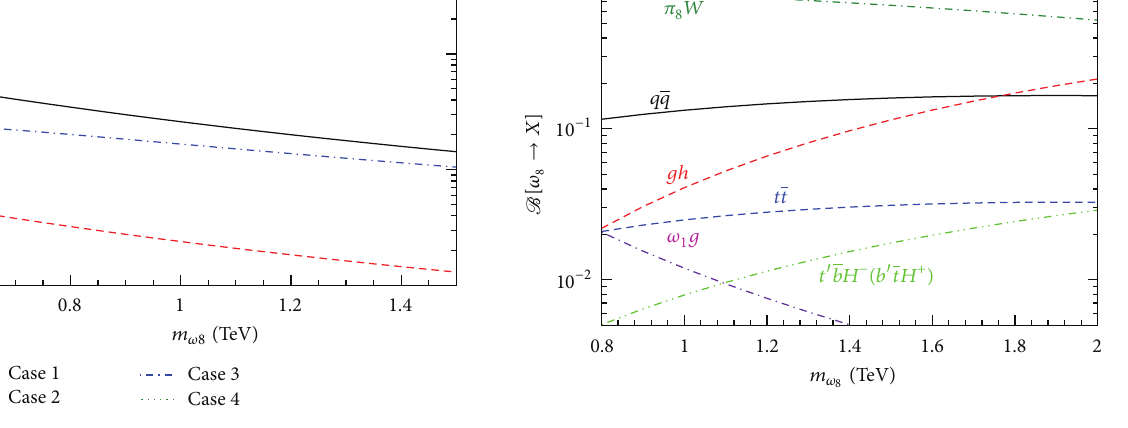
Therefore 𝜔 8 → 𝑔𝐴 is also absent. One might think that any of 𝜔 8 → 𝜋 8 ℎ/𝐻/𝐴 could become important if kinematics allows. These are absent for the same reason that 𝑊 from 𝜔 8 → 𝜋 8 𝑊 is purely transverse. The rates for channels 𝑡 󸀠 𝑏𝐻 − (𝑏 󸀠 𝑡𝐻 + ) and 𝑔ℎ are plotted in Figure 14. In Type-II case, there is no free quark to a final state with neutral Higgs. Since we find 𝑡 󸀠 𝑡 and 𝑏 󸀠 𝑏 via charged Higgs exchange to be very small we do not plot them here. The free quark decays with charged Higgs are present if 𝑚 𝐻 ± < 𝑚 𝜔 𝑚 𝑄 . The rates are at the same order as the free quark decay given in (9), which is expected since the heavy quark decay rates to 𝑡𝑊 are dominated by the Goldstone